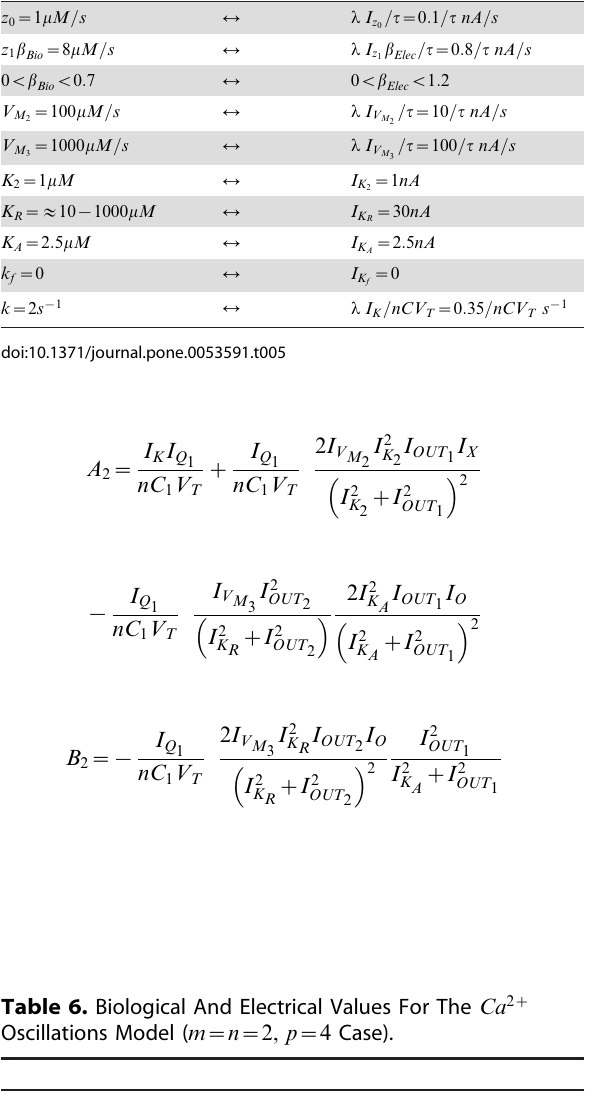
Biological Values Electrical Values (Scaling Factor l : 10%)